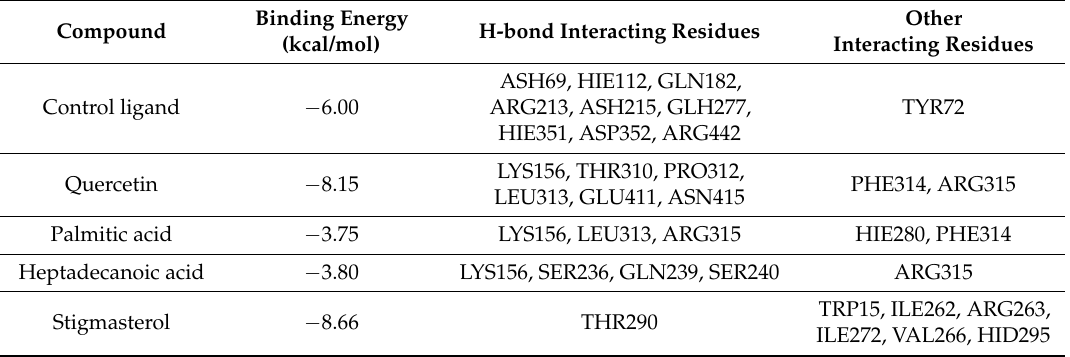
Table 5. Molecular interaction results of α -glucosidase enzyme protein with the known inhibitor (Quercetin) and the active compounds quantified using GC-MS.